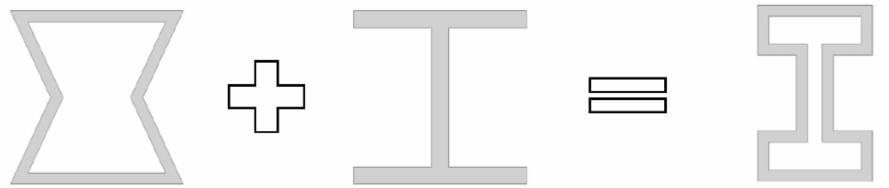
Figure 1. Recessed I-shaped honeycomb structure inspired by the combination of the traditional recessed hexagon and